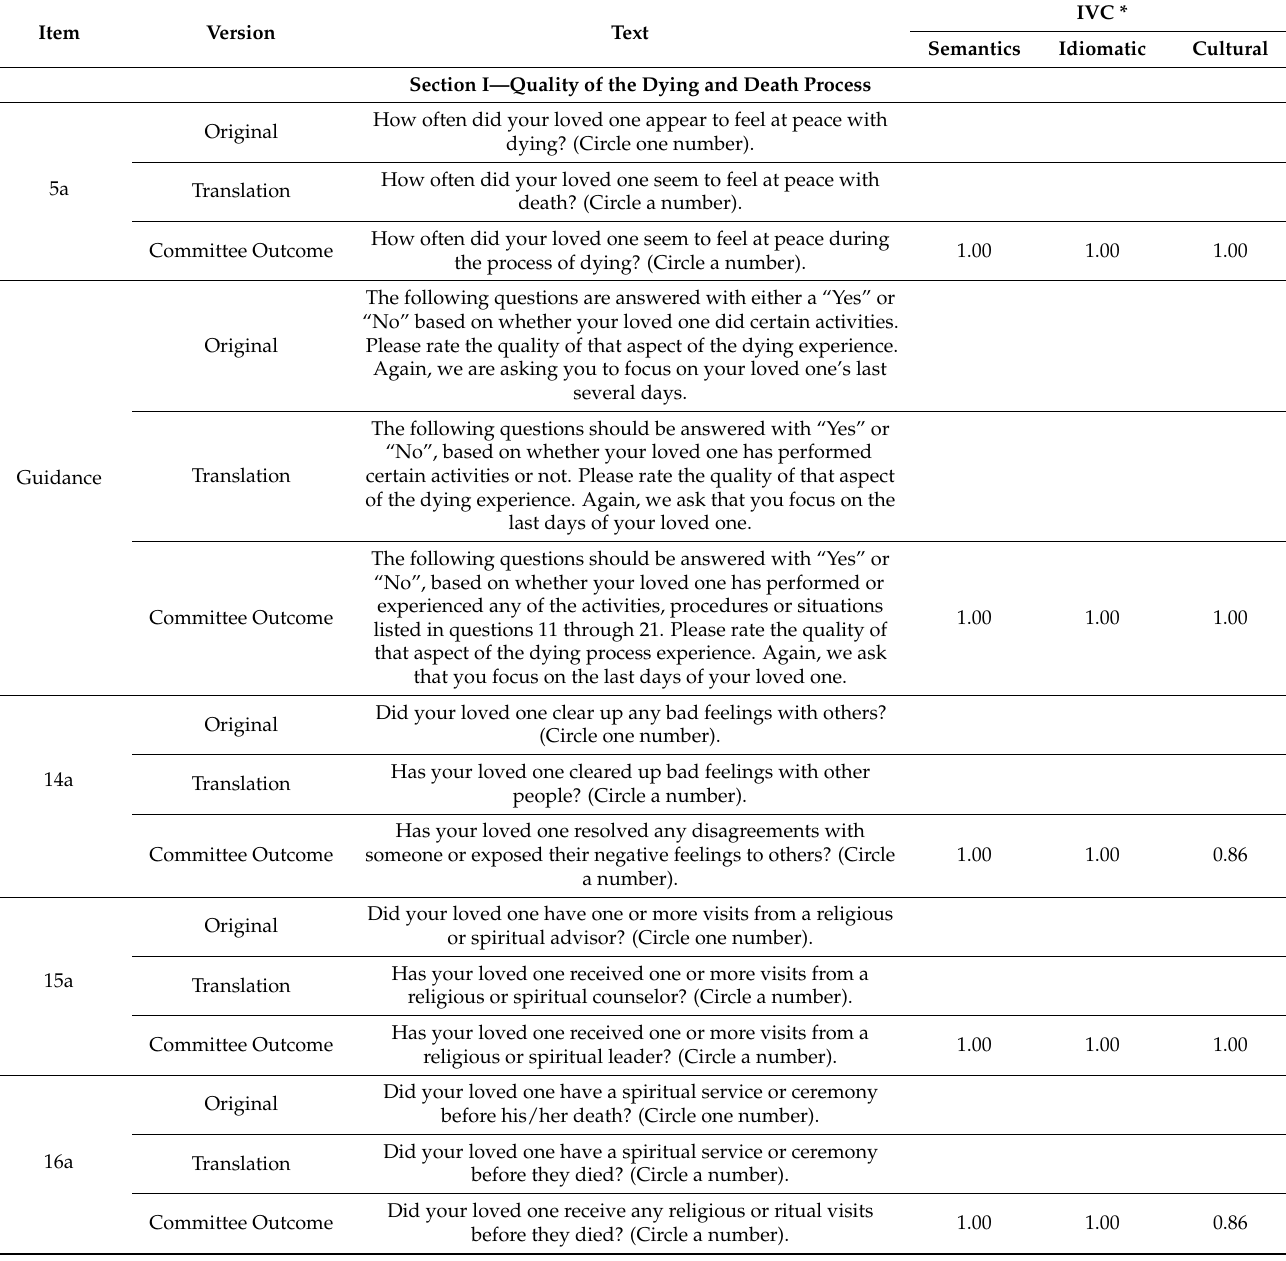
Table 1. Items of the QODD version translated into Portuguese (Brazil) that had a content valida- tion index = 0.86 and/or that underwent changes through inferences from the Experts Committee, Botucatu, SP, Brazil,